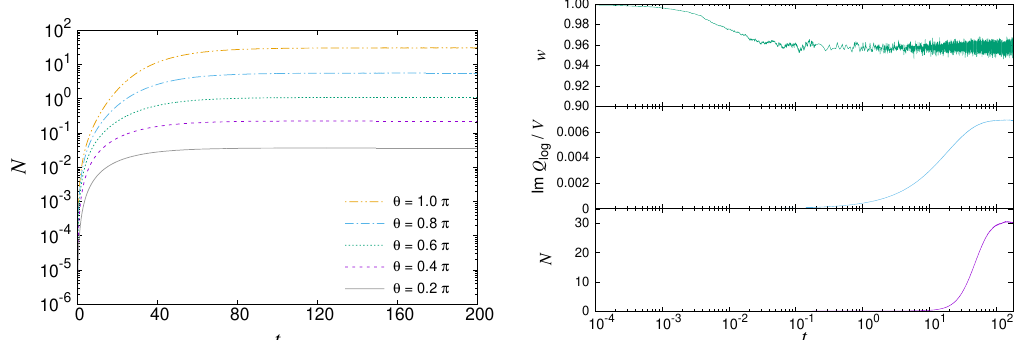
Figure 9 . (Left) The history of the unitarity norm is plotted for the punctured model with N the log de(cid:12)nition (2.11) of the topological charge for various (cid:18) with ( (cid:12); L ) = (12 ; 20). (Right) The histories of the average plaquette and the imaginary part of the topological charge density are compared with that of the unitarity norm for the punctured model with the log de(cid:12)nition (2.11) N of the topological charge for ( (cid:12); L ) = (12 ; 20) with (cid:18) = (cid:25) . Note that the horizontal axis represents the Langevin time in the log